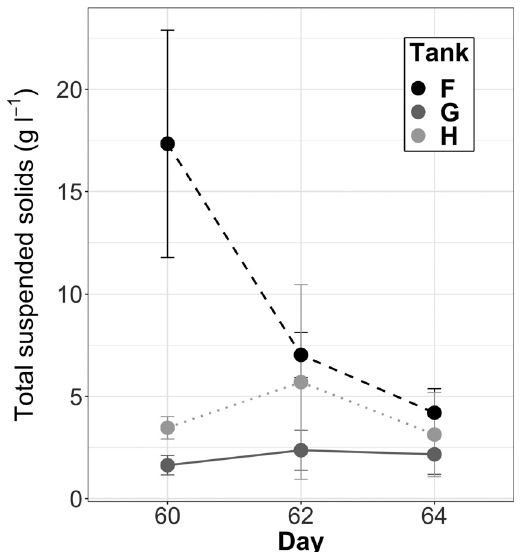
Fig. 5. Mean (±SD) total suspended solids in the fish (F), sea cucumber (G) and halophyte (H) tanks of the RAS during the last week of the experiment